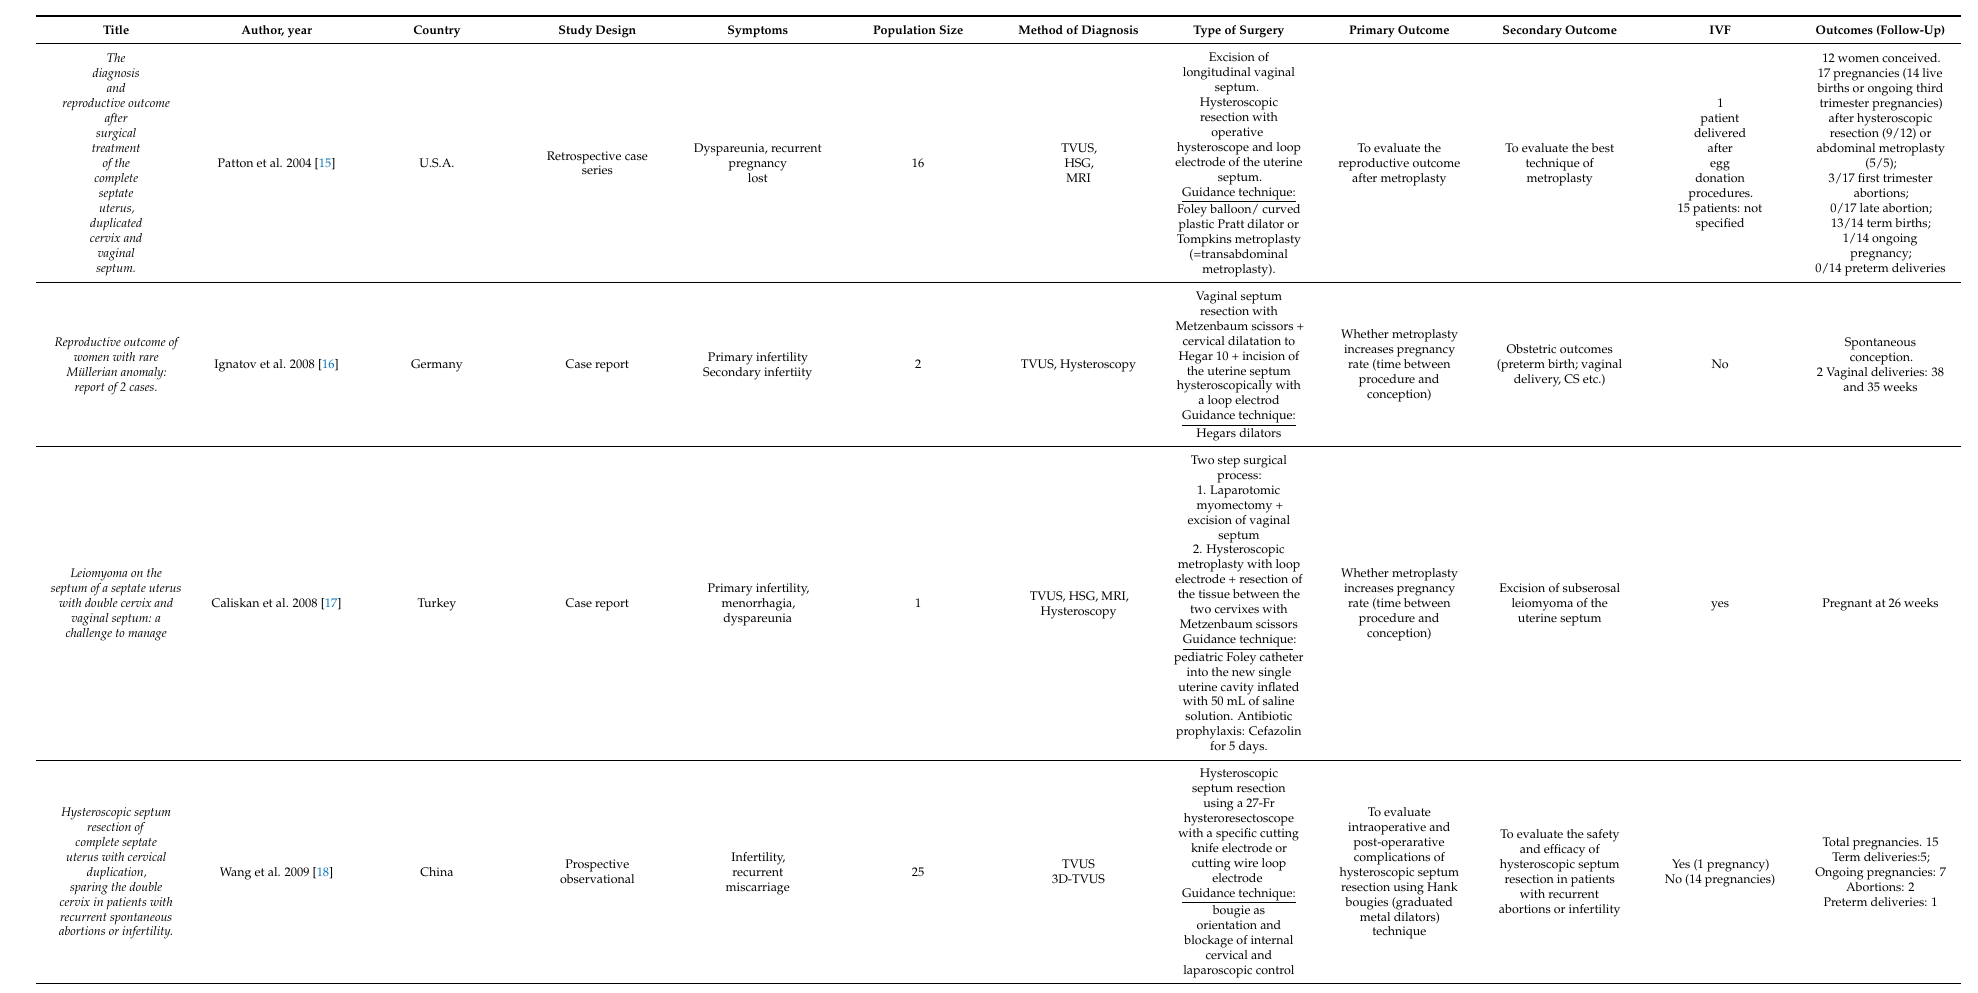
Table 1. Characteristics of the included